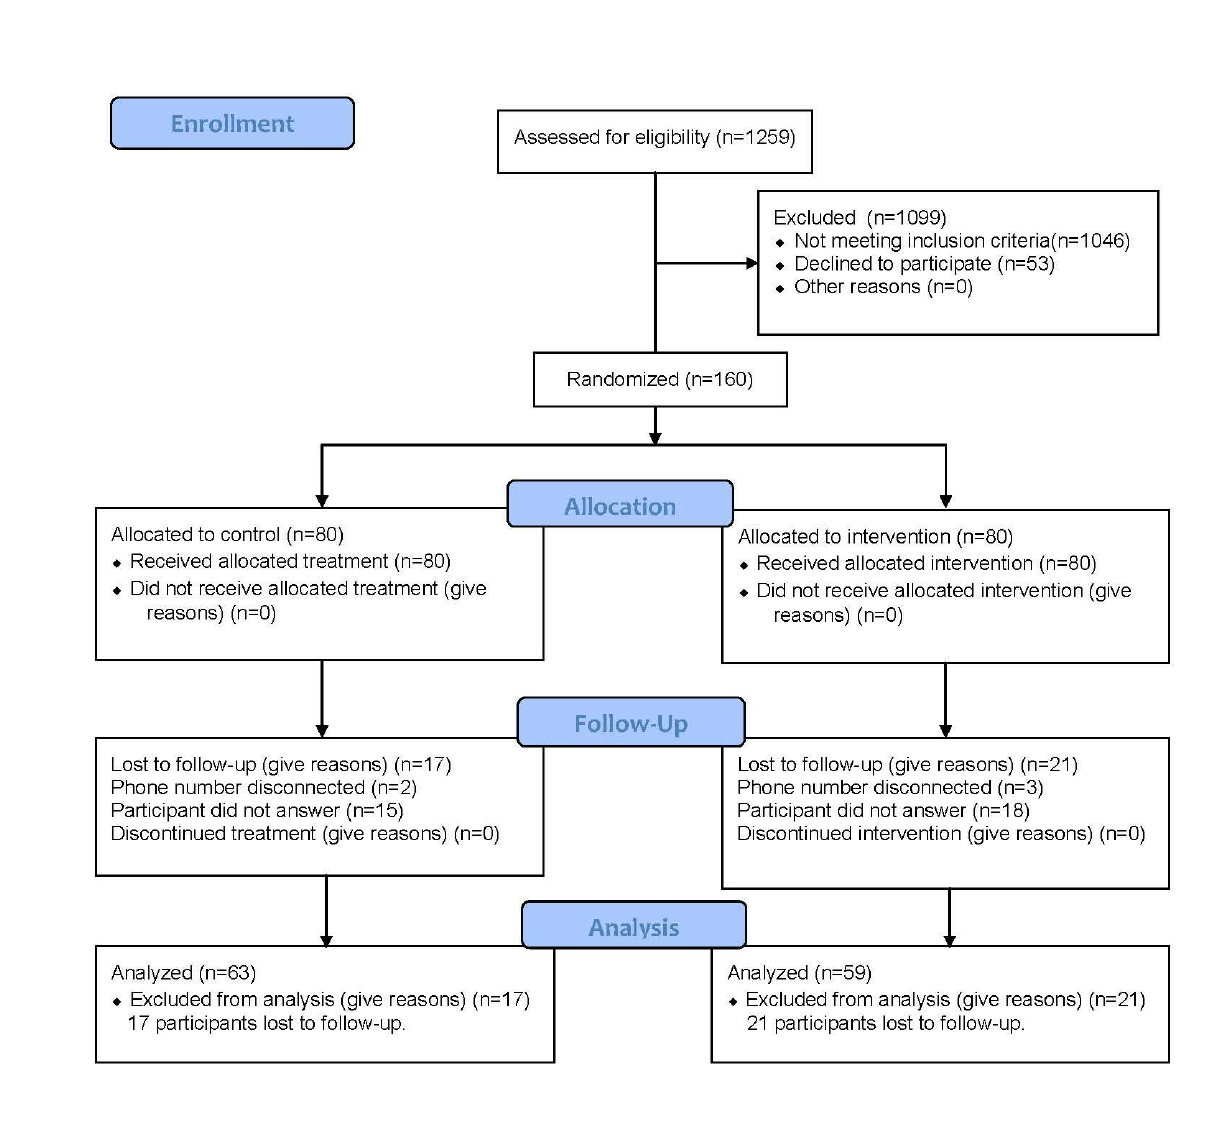
Figure 4. Profile of the randomized controlled trial (using CONSORT